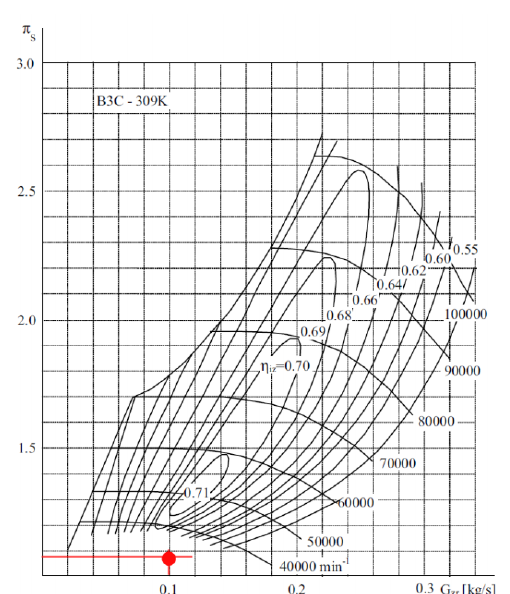
Figure 13: Performance map of the tested compressor with the oper- ating point marked in red